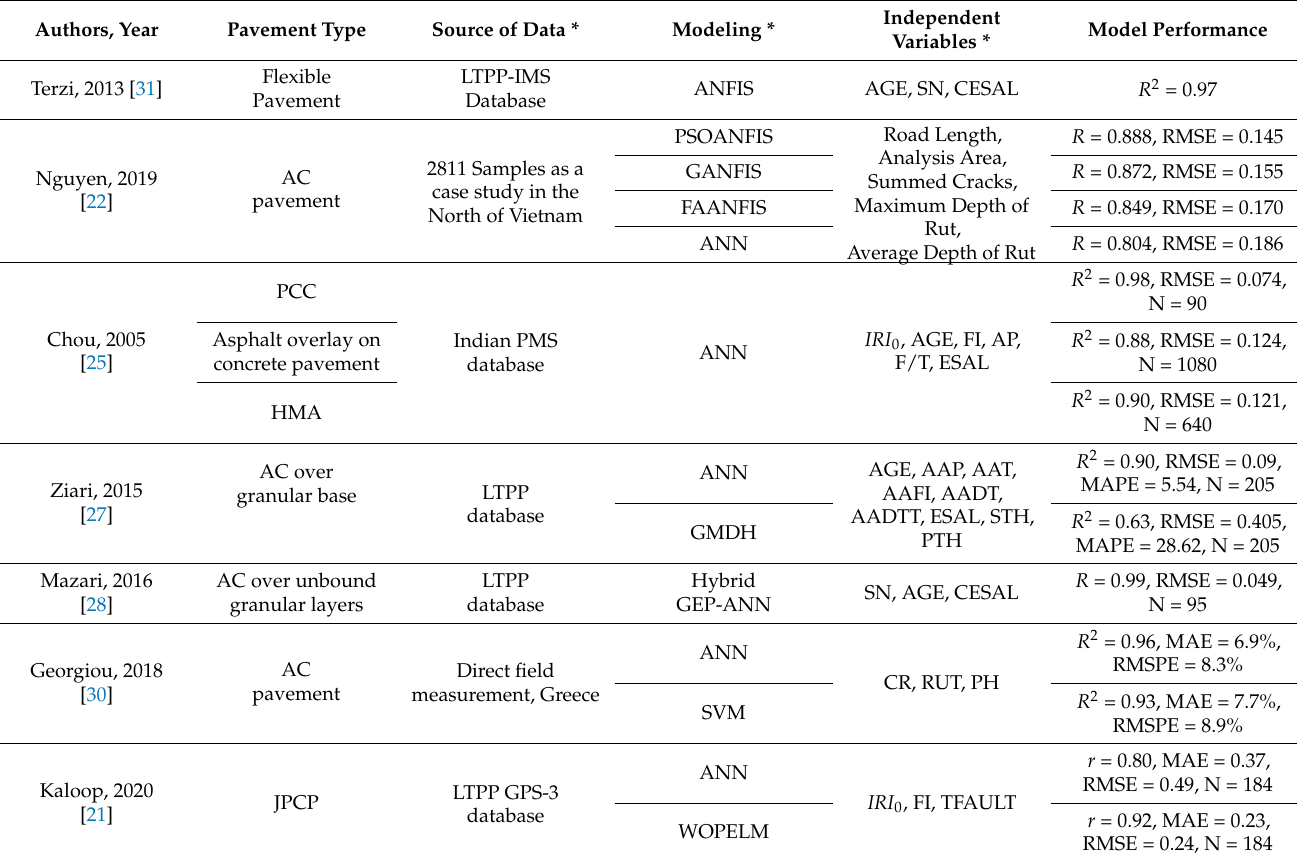
Table 1. Summary of some literature IRI prediction